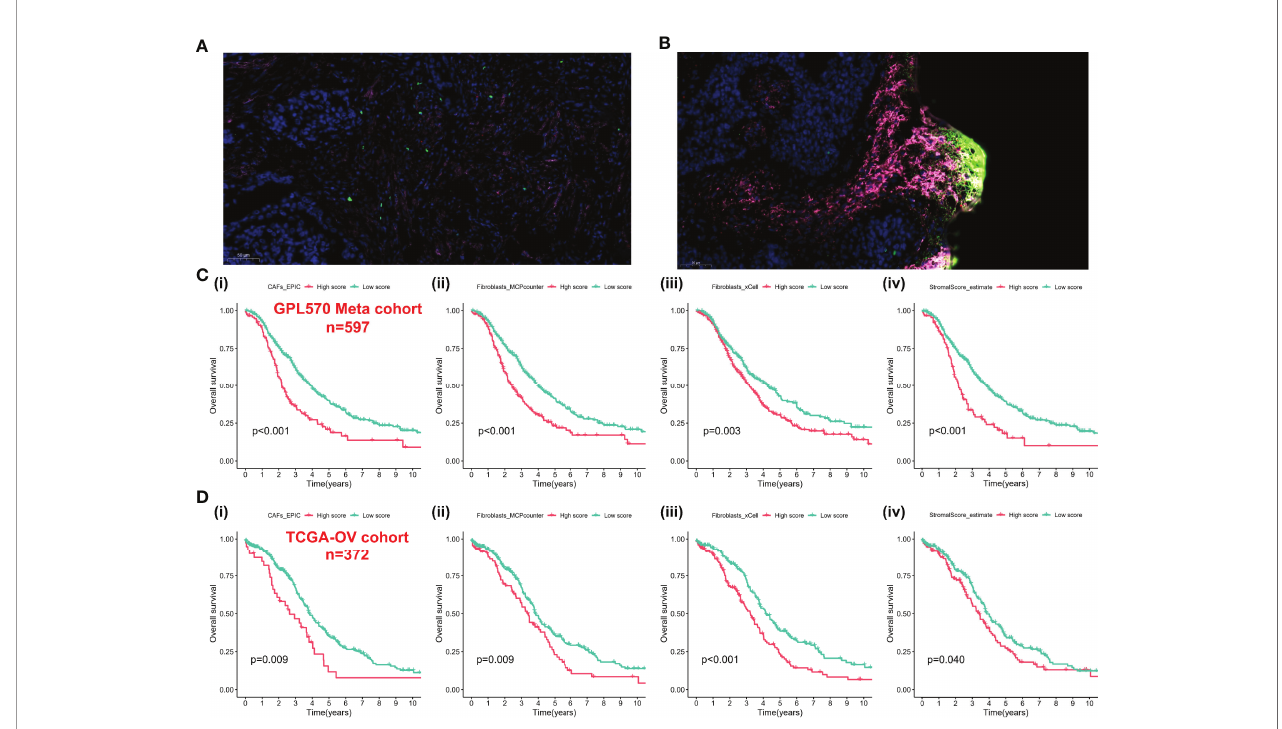
FIGURE 2 | CAFs spatially associate with Treg cells and survival analysis-based CAFs and stromal score. (A) Immuno fl uorescence staining of the original ovarian tissue samples. (B) Immuno fl uorescence staining results of recurrent ovarian tissue samples. (C) The Kaplan – Meier analysis of GPL570 meta-cohort, including CAF_EPIC (i), Fibroblasts_MCPcounter (ii), Fibroblasts_xCell (iii), and StromalScore_estimate (iv). (D) The Kaplan – Meier analysis of TCGA-OV cohort, including CAF_EPIC (i) , Fibroblasts_MCPcounter (ii), Fibroblasts_xCell (iii), and StromalScore_estimate (iv). CAFs, Cancer-Associated Fibroblasts; Tregs, Regulatory T